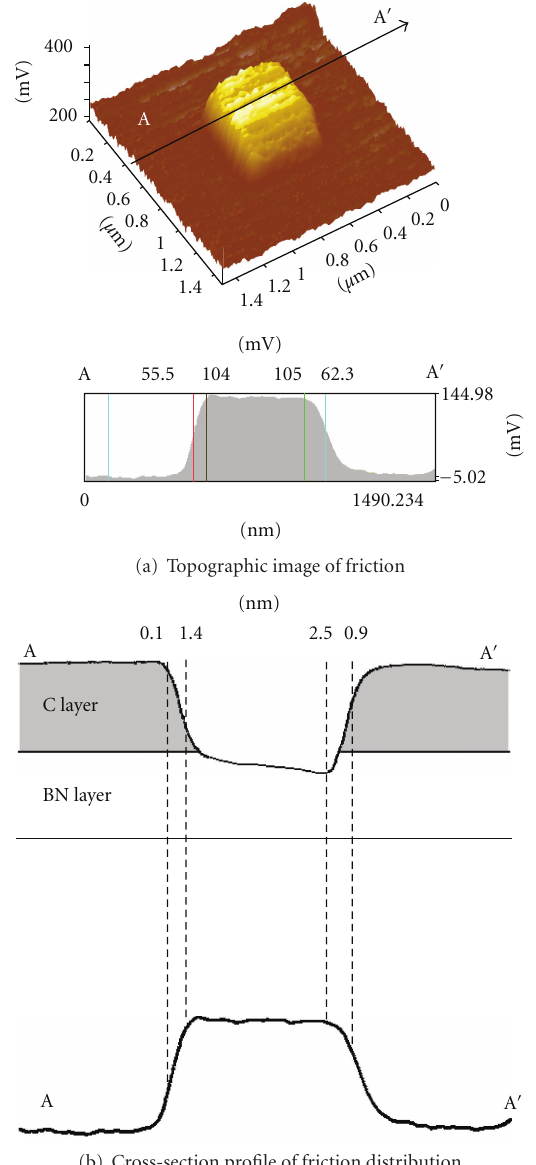
Figure 21: (a) Profile and cross-sectional images of friction distribution and (b) model of friction versus wear track for 4-nm- period (C/BN)n film at 3500 nN